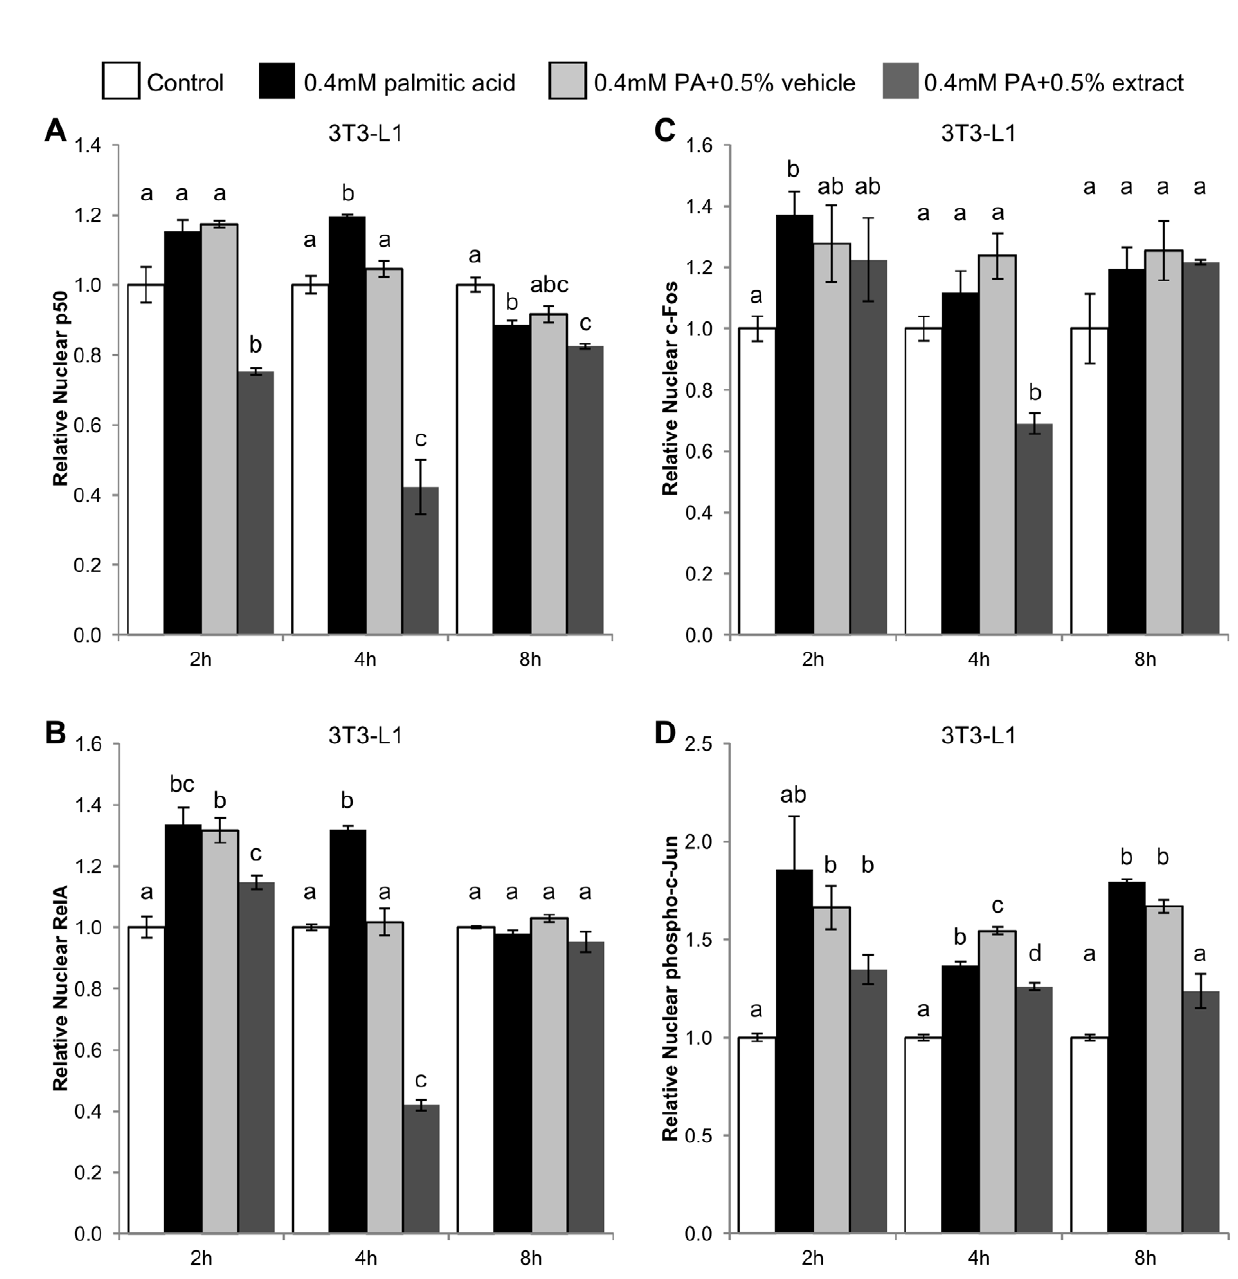
Figure 4. Effect of BEX on nuclear translocation of NF- k B and AP-1 transcription factors over time. Nuclear translocation of NF- k B (A) p50, (B) RelA/p65, AP-1 (C) c-Fos, and (D) phospho-c-Jun subunits in 3T3-L1 cells. Measurements are relative absorbance at 450 nm from a response- element DNA binding colormetric ELISA on nuclear extracts from cells treated with palmitic acid (PA, 0.4 mM) in combination with BEX (125 m g/ml or 0.5%, v/v) or ethanol vehicle (0.5%, v/v). Mean 6 standard error over 3 trials, n $ 3 wells per trial. Mean results were compared between treatments at the same time point. Differences between means are statistically significant if columns do not share any common letters (p , 0.05, one-way ANOVA with Tukey’s multiple comparison test).